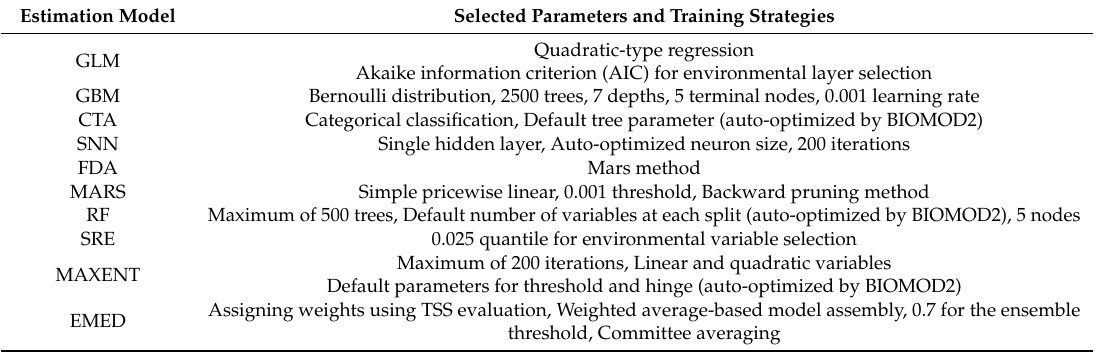
Table 5. Selected parameters and training strategies for the estimation